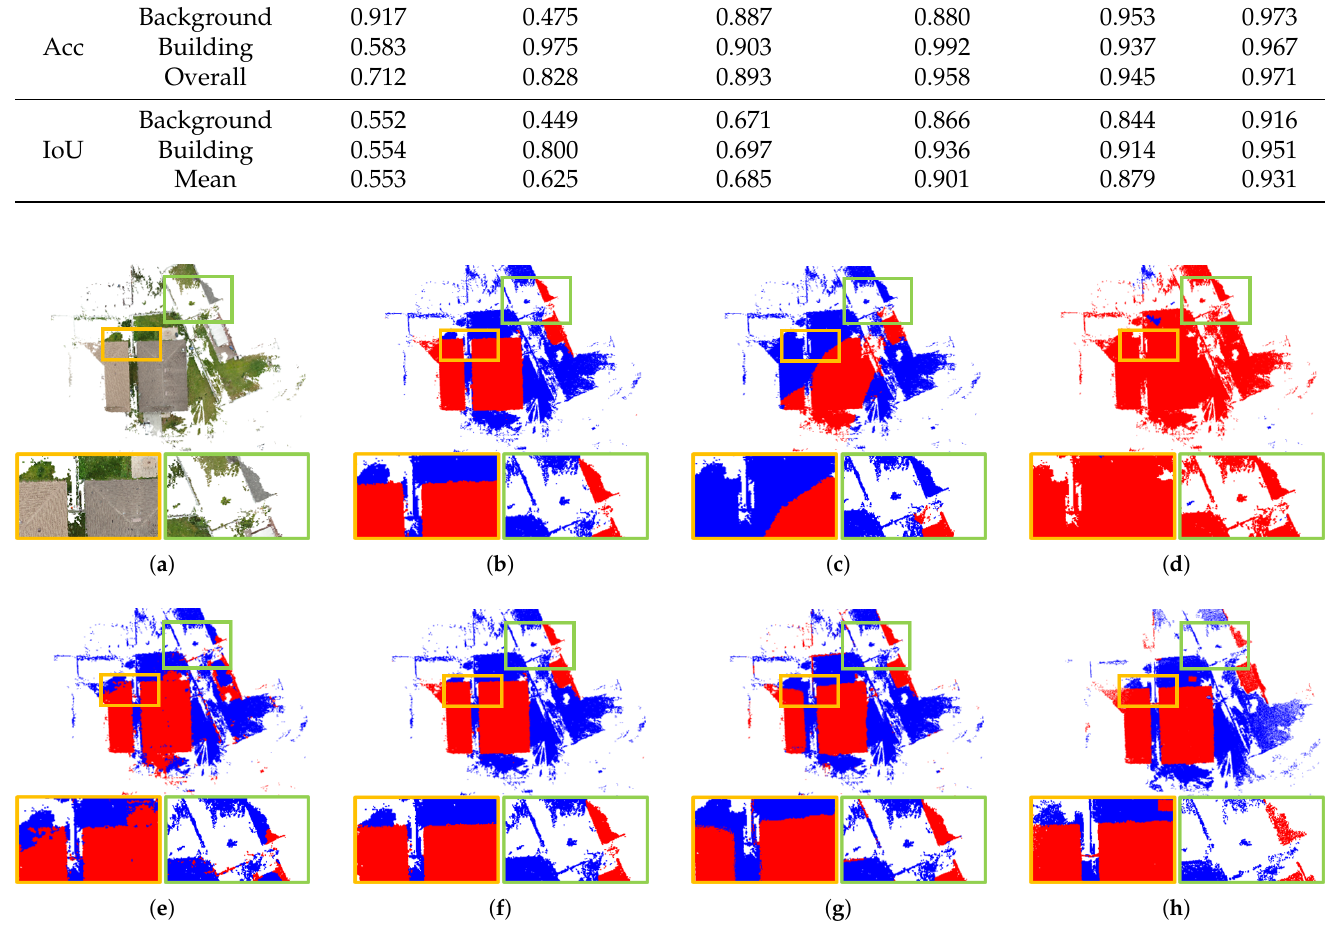
Figure 4. Comparison of different semantic segmentation methods on Dataset I. ( a ) Origin PointCloud ( b ) Ground Truth ( c ) PointNet ( d ) PointNet++ ( e ) RandLANet ( f ) PointFormer ( g ) PointNeXt ( h )